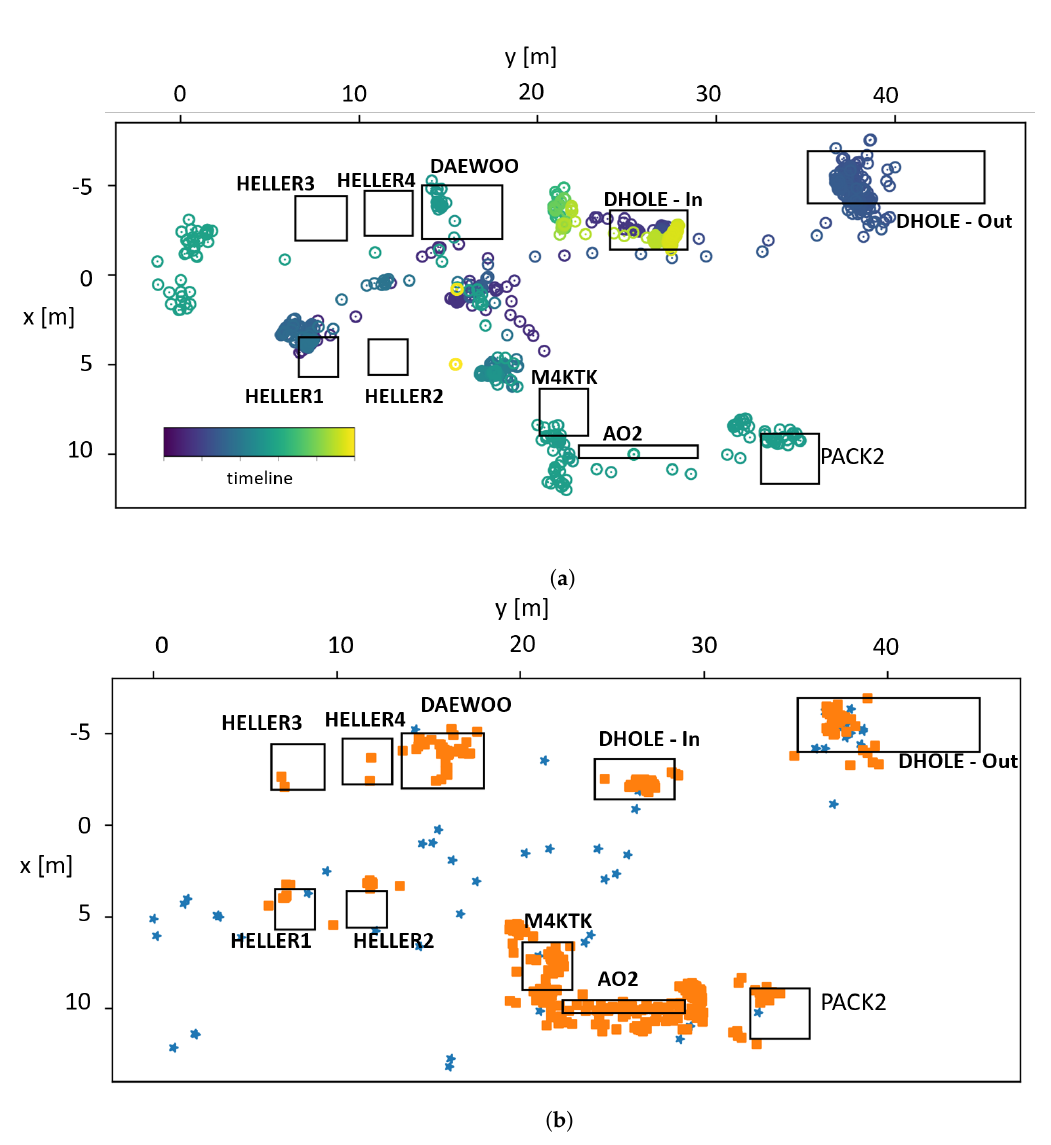
Figure 4. The distribution analysis of the positional data supports the identification of the states of the internal inventories, and the waiting and cycle times. ( a ) Tracked path of one product on the shop-floor. The rectangles define the workstations and the dots represent the positional data. The timeline is presented by the colours of the dots. ( b ) The discovered status is based on positional data. The blue stars are the transportation, while the orange markers are the queueing